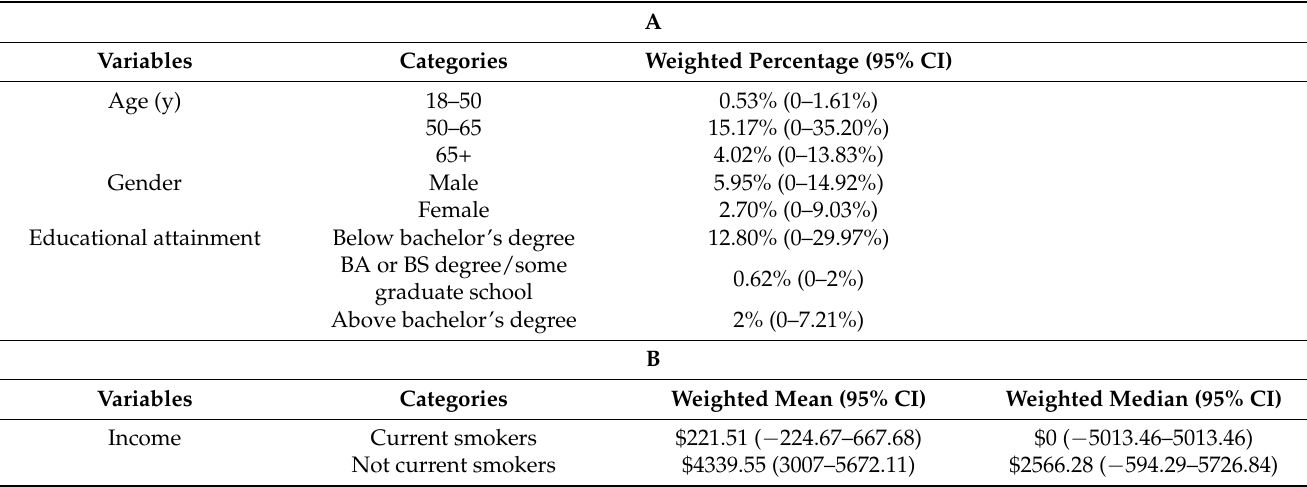
Table 2. ( A ) Demographics by current smoking status among Chinese immigrants. ( B ) Income for previous month by smoking status among Chinese immigrants.